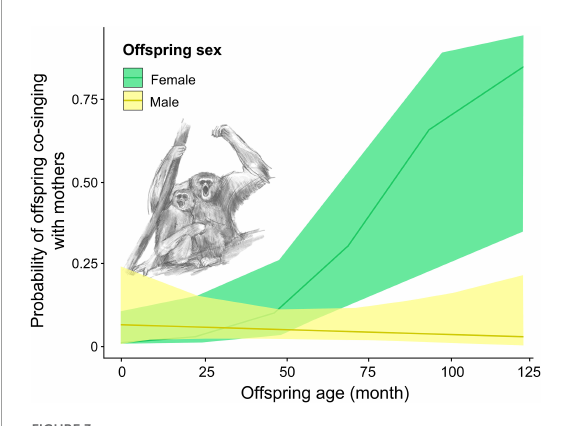
FIGURE3 The probability of offspring Hylobates moloch co-singing with their mothers throughout the ages in Gunung Halimun-Salak National Park, Indonesia, between 2009 and